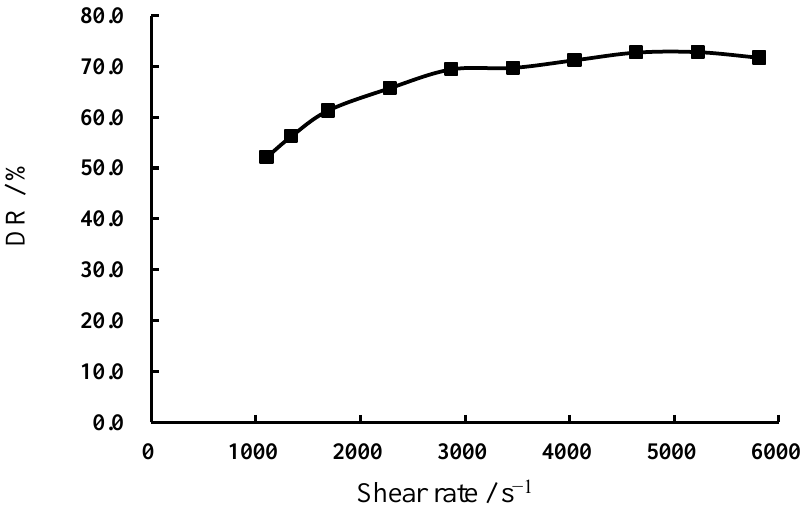
Figure 2. Relationship curve of drag-reduction rate with shear rate.